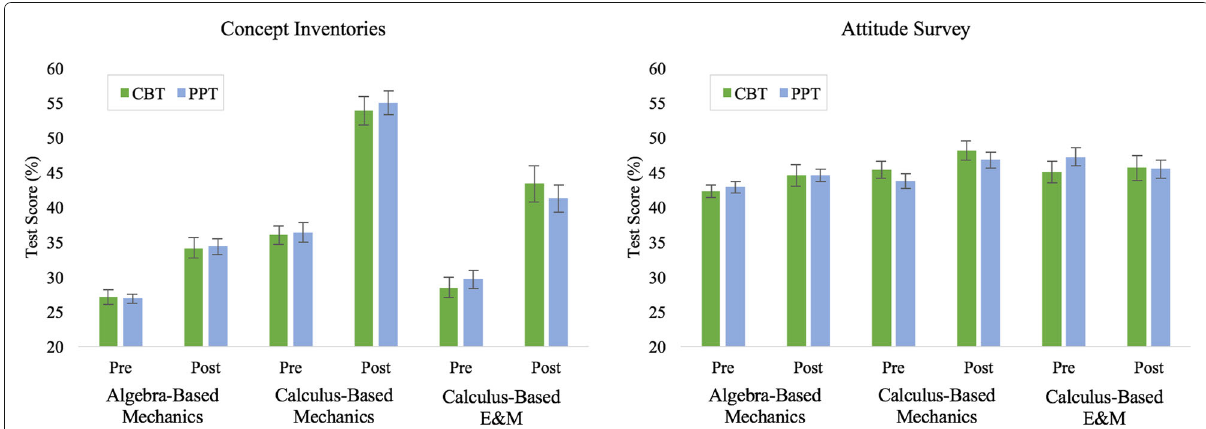
Fig. 5 A comparison between CBT and PPT administered concept inventories and attitudinal surveys based on AS model 3 and CI model 3. Error bars are 1 standard error. All of the differences between CBTs and PPTs were small, none of the differences were statistically significant, and neither assessment condition was consistently higher than the other. These results indicate that there is no difference in performance between assessments administered as CBTs and those administered as